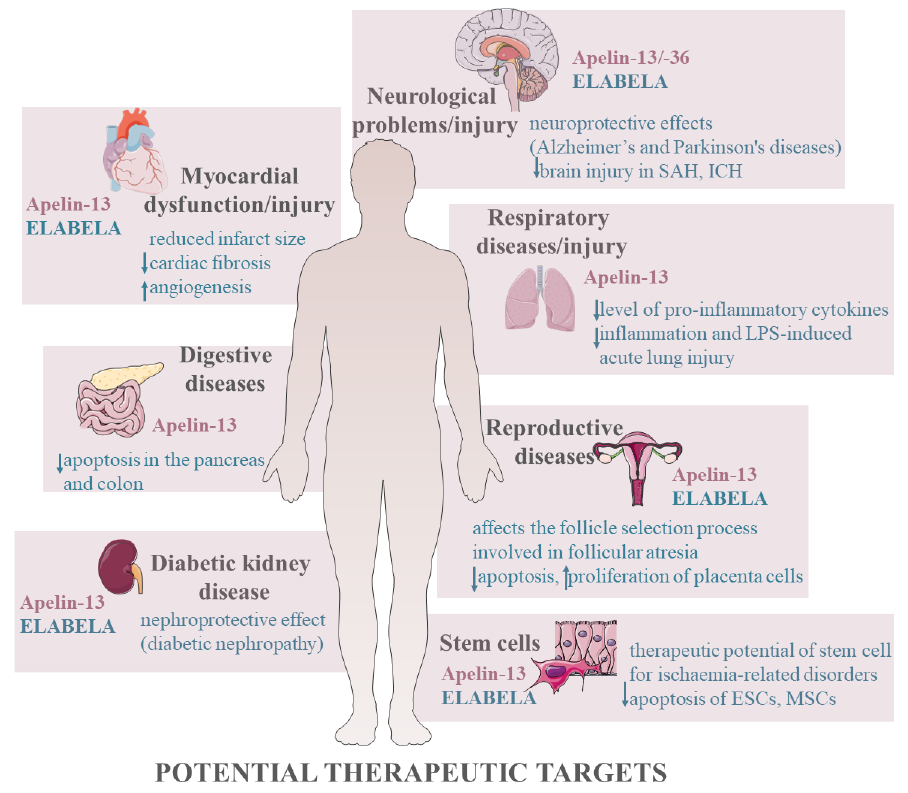
Figure 4. Potential therapeutic targets of apelinergic system. Stimulation, ↑ ; inhibition, ↓ . Abbreviations: SAH, subarachnoid haemorrhage; ICH, intracerebral haemorrhage; LPS, lipopolysaccharide; ESCs, embryonic stem cells; MSCs, mesenchymal stem cells.